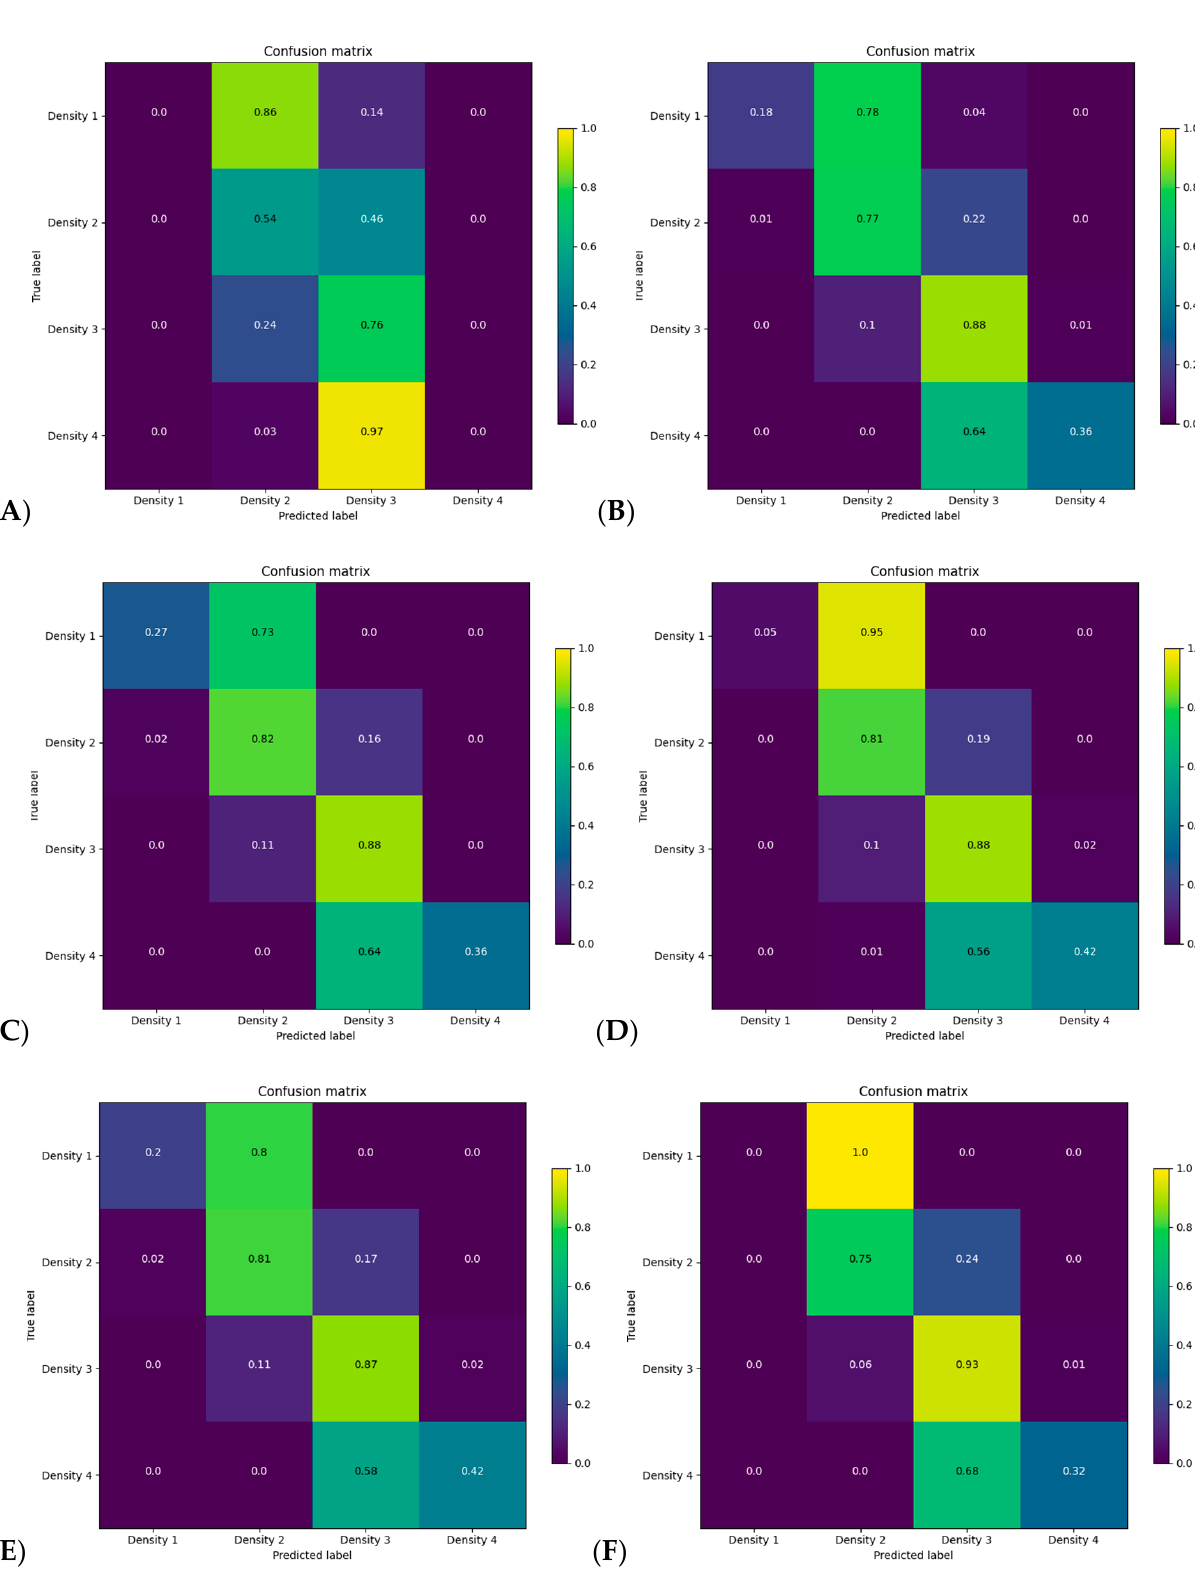
Figure 4. Confusion matrix for categorical breast density for each model on every screening year of the test dataset without including clinical history for ( A ) history, ( B ) for processing, ( C ) for presentation, ( D ) synthesized 2D, ( E ) digital breast tomosynthesis, mammograms and ( F ) all modalities models.